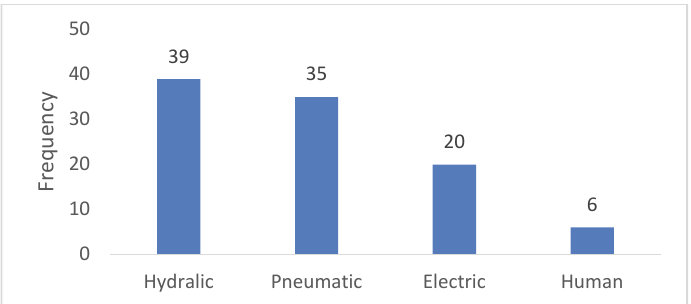
Fig. 2 Pareto analysis of Projection Spot Welding